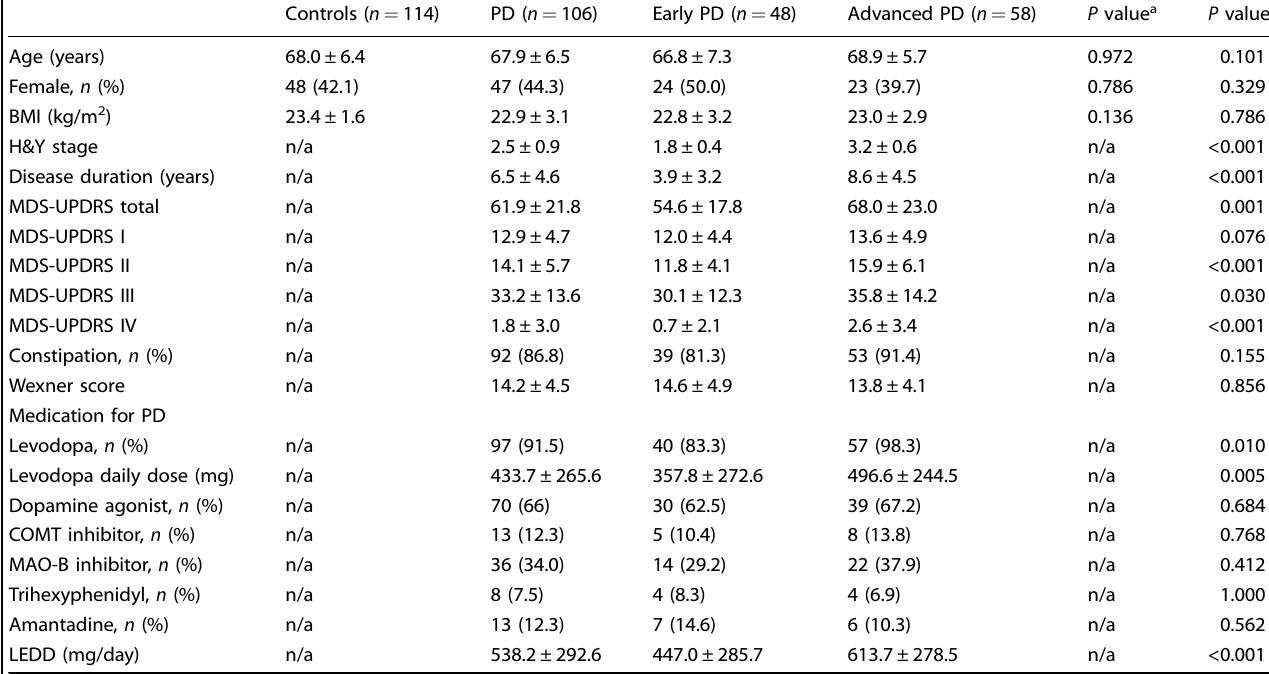
Data are shown as mean ± standard deviation or n (%). Comparisons between groups were assessed with the Student ’ s t test or Mann – Whitney U test for quantitative variables, and Fisher ’ s exact tests for categorical variables. Early PD was de fi ned by an H&Y stage < 2.5, and advanced PD was de fi ned by an H&Y stage ≥ 2.5. PD Parkinson ’ s disease, BMI body mass index, H&Y stage Hoehn and Yahr stage, MDS-UPDRS Movement Disorder Society-sponsored revision of the Uni fi ed Parkinson ’ s Disease Rating Scale, COMT catechol-O-methyl transferase, MAO-B monoamine oxidase-B, LEDD, levodopa equivalent daily dose. a Controls vs. PD. b Early PD vs. Advanced